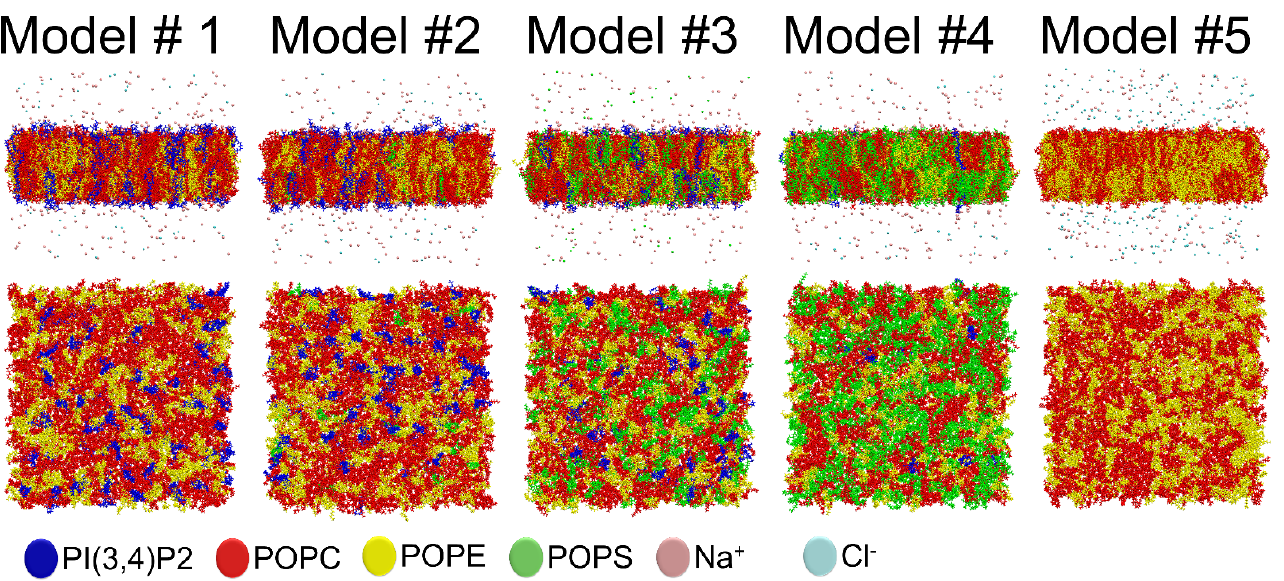
Figure 5. The 3D structures of the outer mitochondrial membrane models after 300 ns simulation. On top are shown lipid bilayers or membrane models (Table 1) from the side view. Below are shown the lipid headgroup region of one membrane leaflet from the top view. The different lipid species and ions are shown as stick models with distinct colors. Solvent is omitted for clarity.